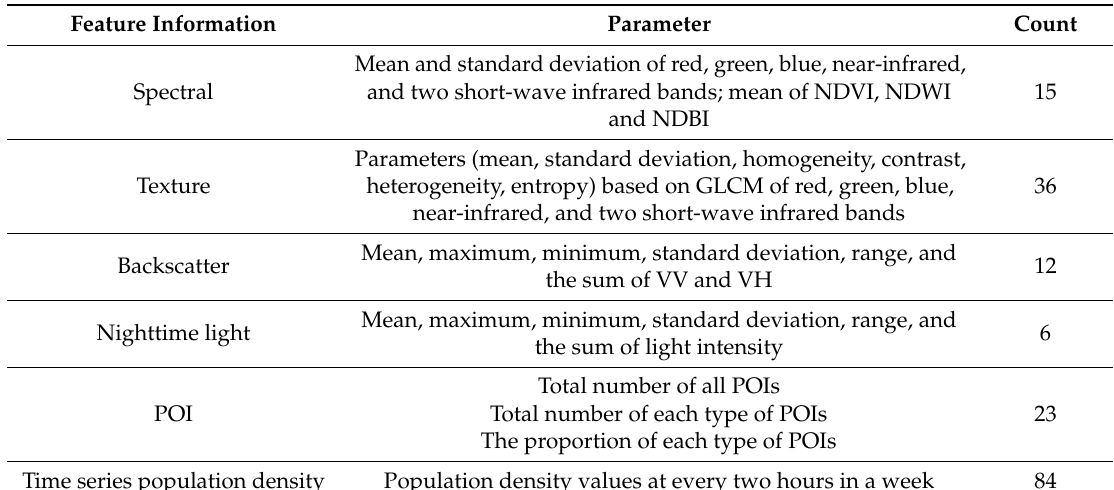
Table 2. Summary of